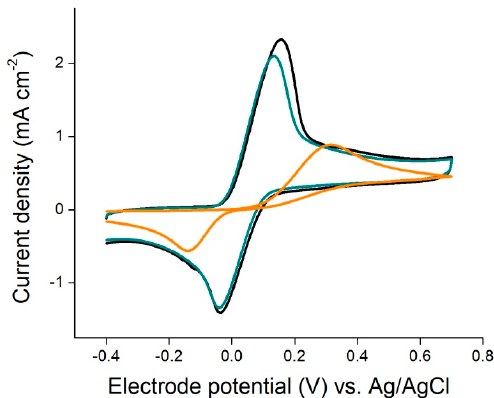
Figure 2 . Scanning electron images of electrodes printed with CNT ink with polystyrene beads at magnifications of 5000× ( a ) and 71,235× ( b ), and a cross section obtained by focused ion beam ( c ).